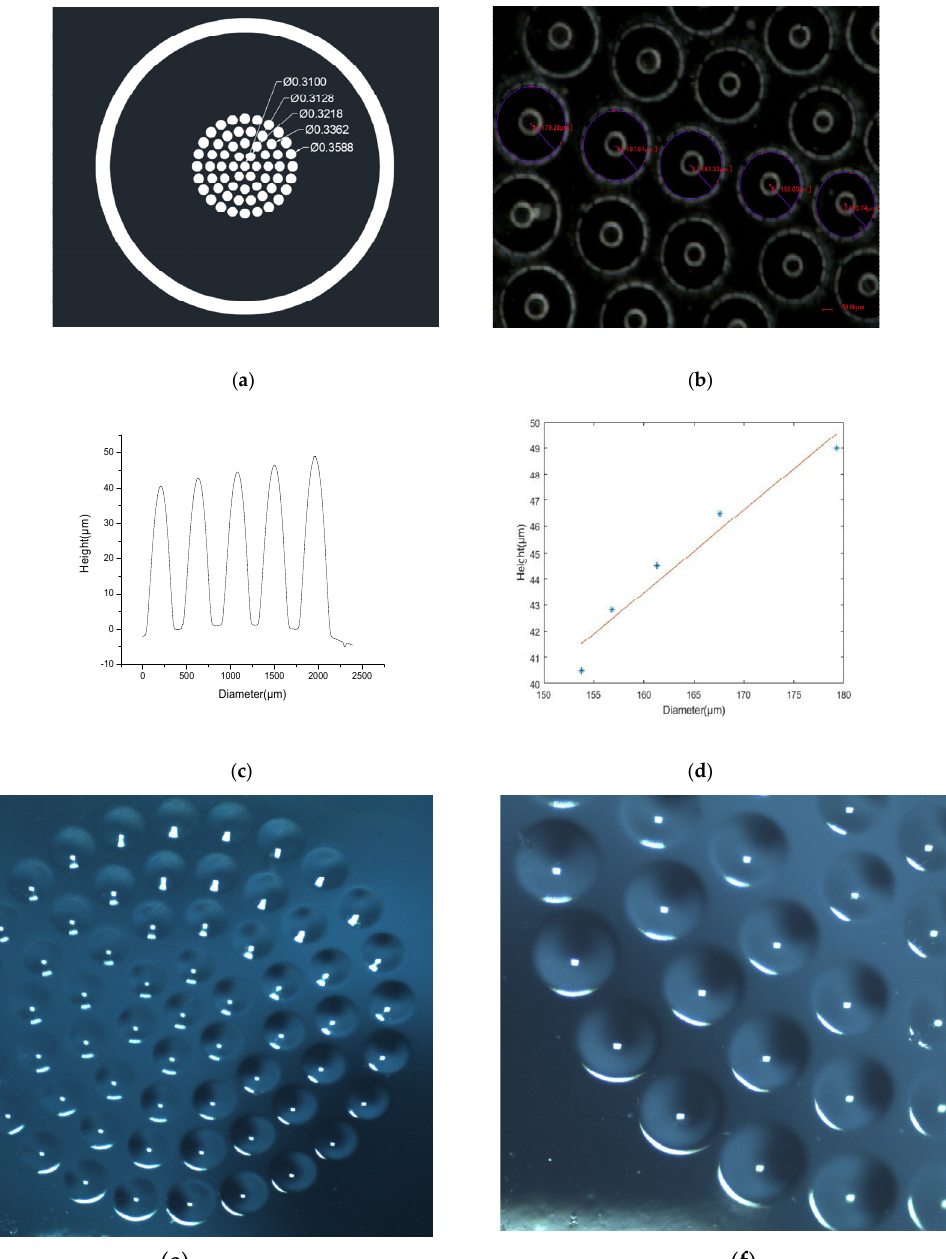
Figure 8. Measurement of the ommatidium. ( a ) The designed MLA on the mask; ( b ) the actual MLA; ( c ) the sag height of the ommatidium; ( d ) the linear relationship between the diameters and the height of the ommatidium; ( e , f ) the surface of the compound eye.